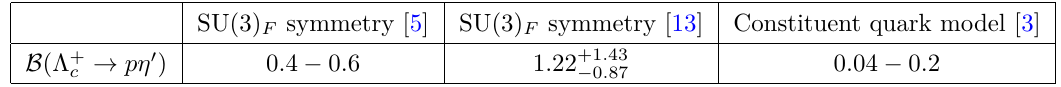
→ pη 0 ) (in units of 10 − 3 ). c